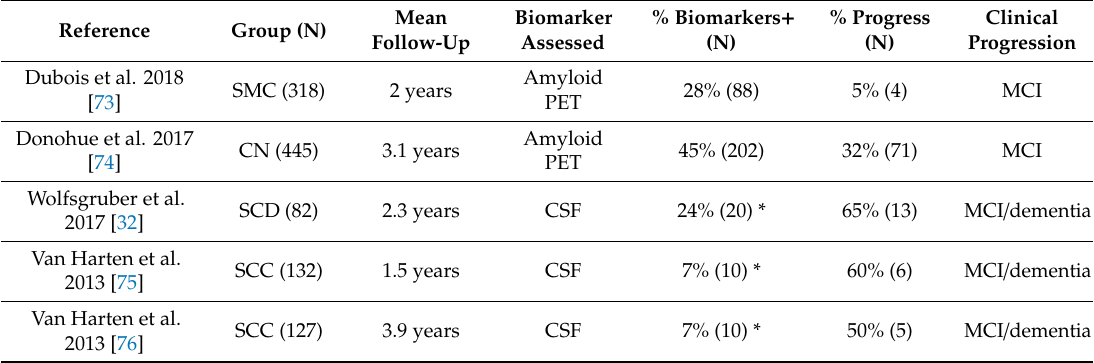
Table 1. Clinical progression in “pre-MCI” subjects with pathophysiological biomarkers